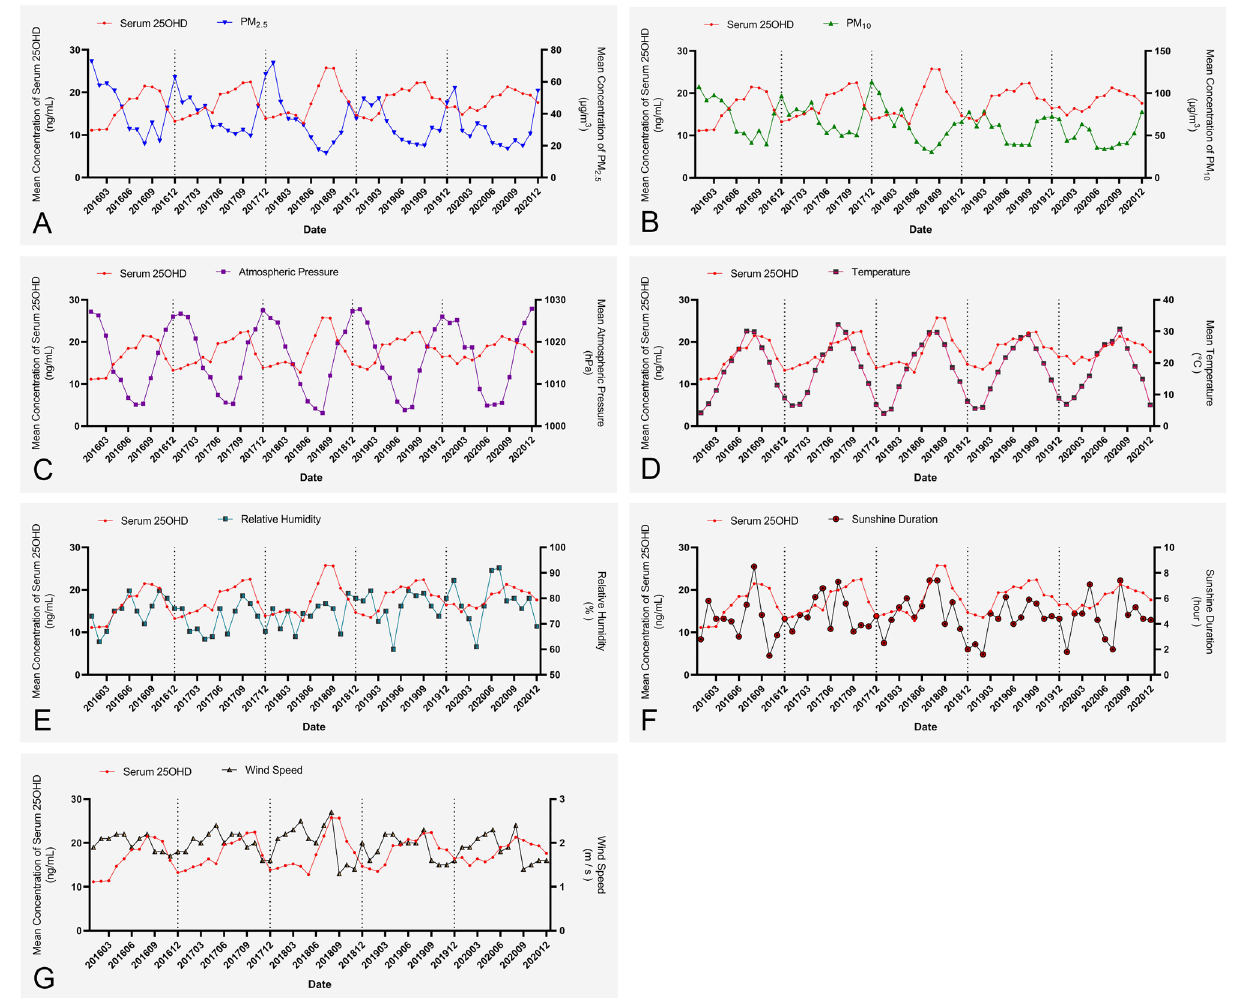
Figure 1. Temporal trends in monthly average serum 25OHD concentration vs. monthly average PM 2.5 concentration ( A ), PM 10 concentration ( B ), atmospheric pressure ( C ), temperature ( D ), relative humidity ( E ), sunshine duration ( F ), and wind speed ( G ) from January 2016 to December 2020. 25OHD 25-hydroxy vitamin D, PM 2.5 particulate matter with an aerodynamic diameter of ≤ 2.5 μm, PM 10 particulate matter with an aerodynamic diameter of ≤ 10